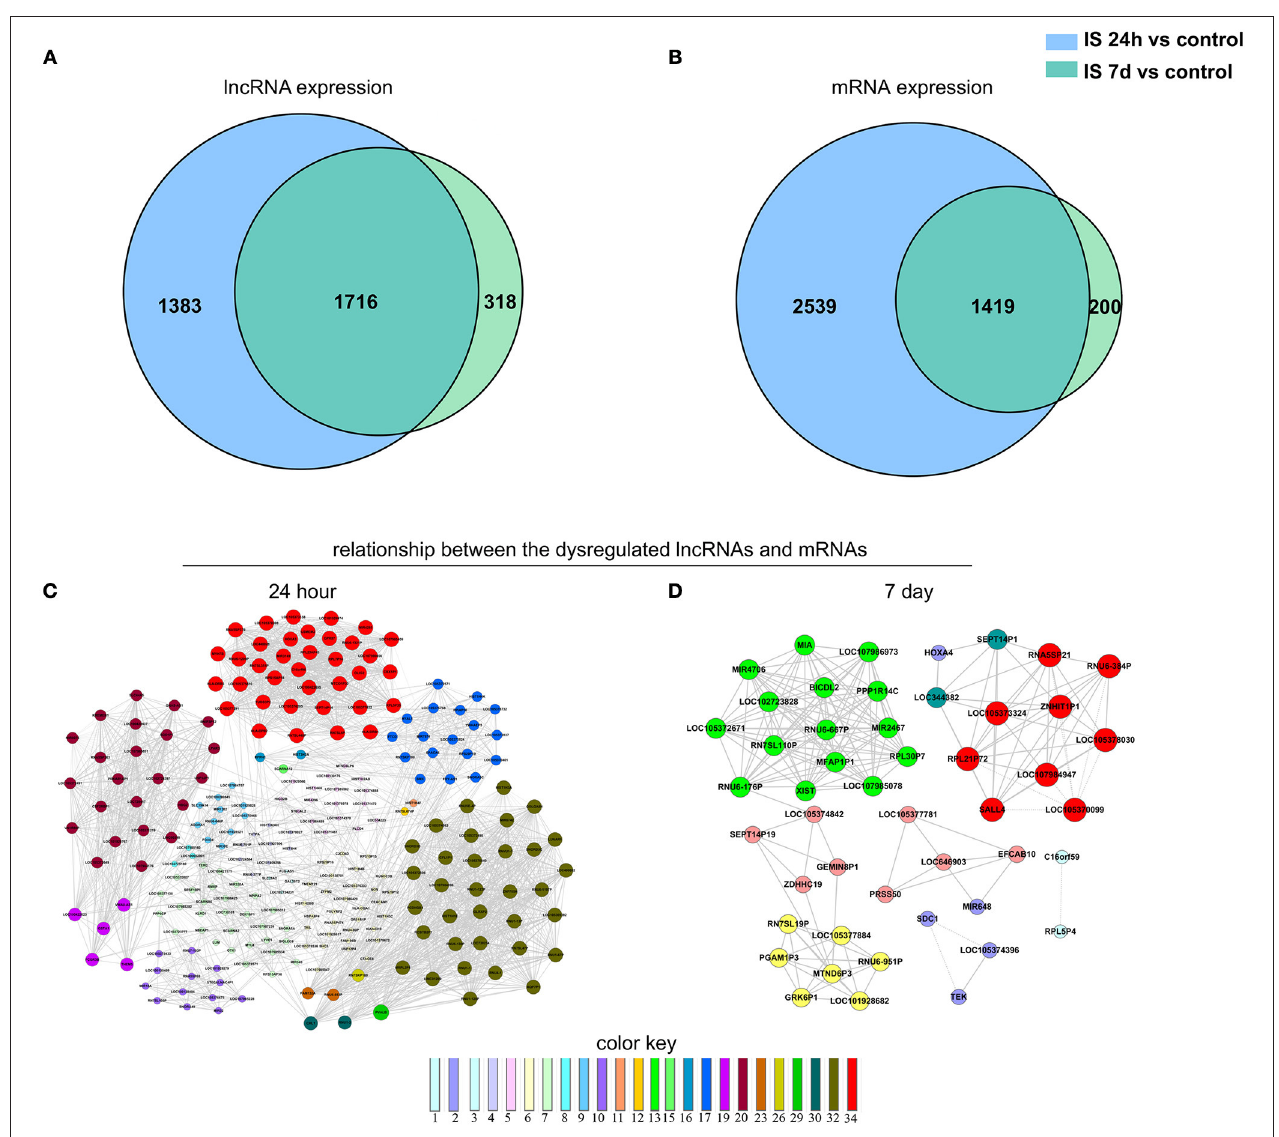
FIGURE 3 | Venn analysis. (A) Venn diagram showing the number of specific and common LncRNAs expressed in IS 24-h patients vs. healthy controls and IS 7-day patients vs. healthy controls. (B) Venn diagram showing the number of specific and common mRNAs expressed in the aforementioned two comparisons. Moreover, the lncRNA-mRNA network was constructed based on the Venn analysis between the differentially expressed LncRNAs and mRNAs. (C,D) show the potential relationship between the dysregulated LncRNAs and mRNAs in the IS patients at 24h and 7 days, respectively. The color key indicates differential gene